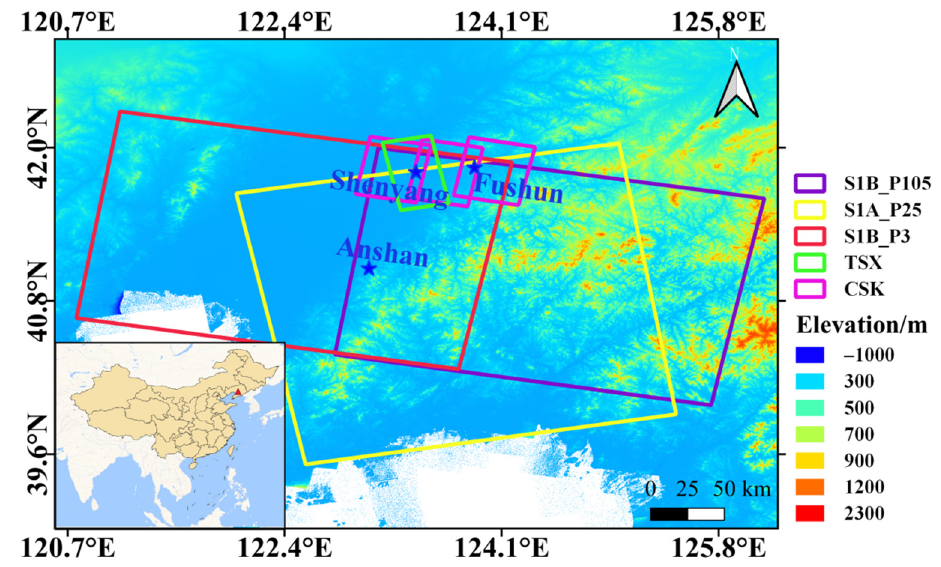
Figure 3. Study area and coverage of Synthetic Aperture Radar (SAR)